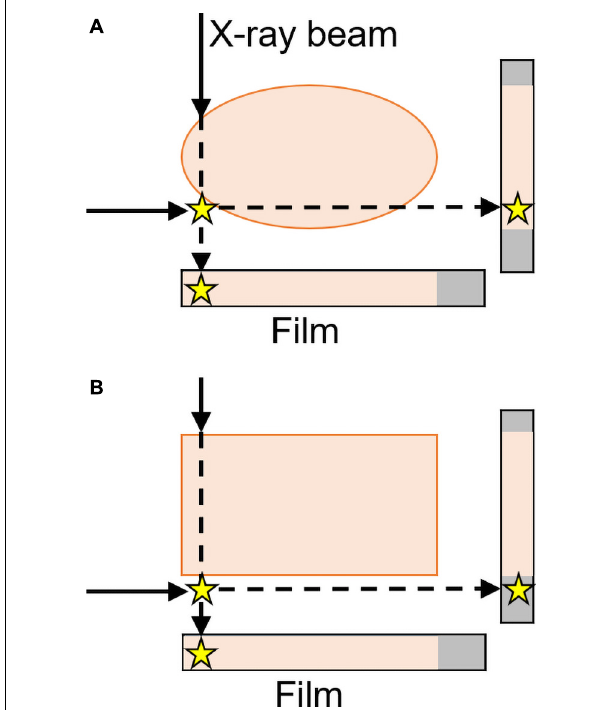
FIGURE 9 | Frontal and lateral projections result in the star (representing an abnormality) either (A) appearing to be within the body or (B) correctly perceived as outside of the rectangular form with a lateral projection. Two views are thus sufficient to localize objects as either inside or outside a region, but only for rectangular parts of the body (Daffner et al., 1982). These “parallax phenomena” are both more likely and less easily resolvable with curved surfaces—like many structures in the body, including the skull and lungs in Figure 5 —than with rectangular structures (inspired by an image from Daffner et al.,